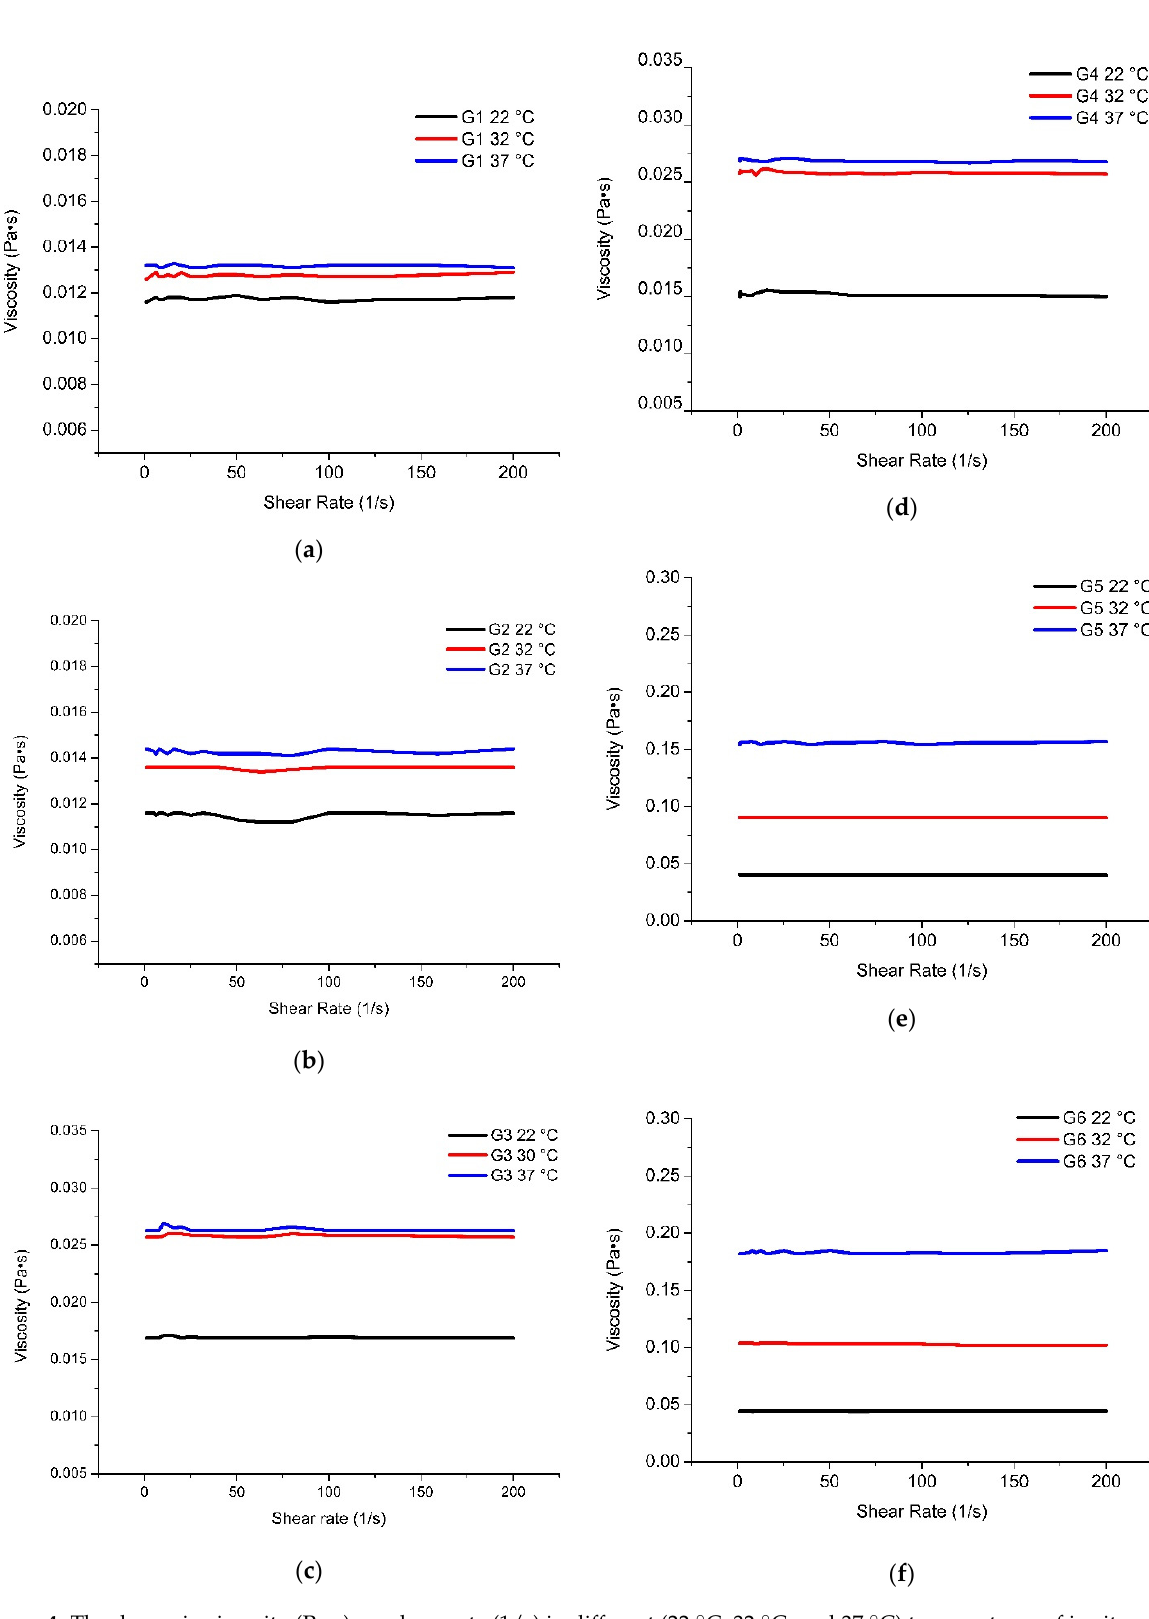
Figure 4. The dynamic viscosity (Pa · s) vs. shear rate (1/s) in different (22 °C, 32 °C, and 37 °C) temperatures of in situ gels: ( a ) G1; ( b ) G2; ( c ) G3; ( d ) G4; ( e ) G5; and ( f ) G6. Storage modulus G (cid:48) shows the elastic properties of the system—the energy that is stored in the material during deformation. The loss modulus G (cid:48)(cid:48) indicates the